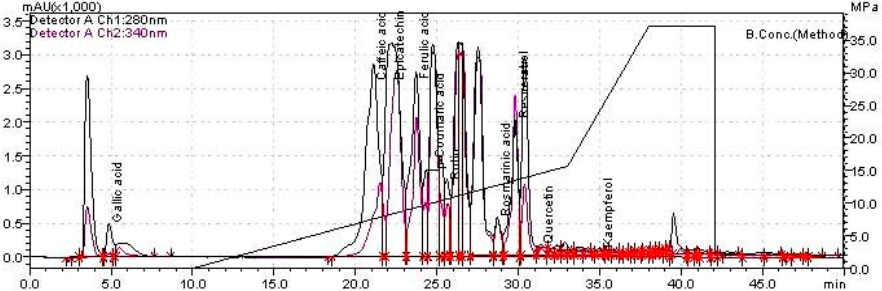
Figure 1. Liquid chromatogram of the Oenothera biennis L. (OB) extract. (chromatographic